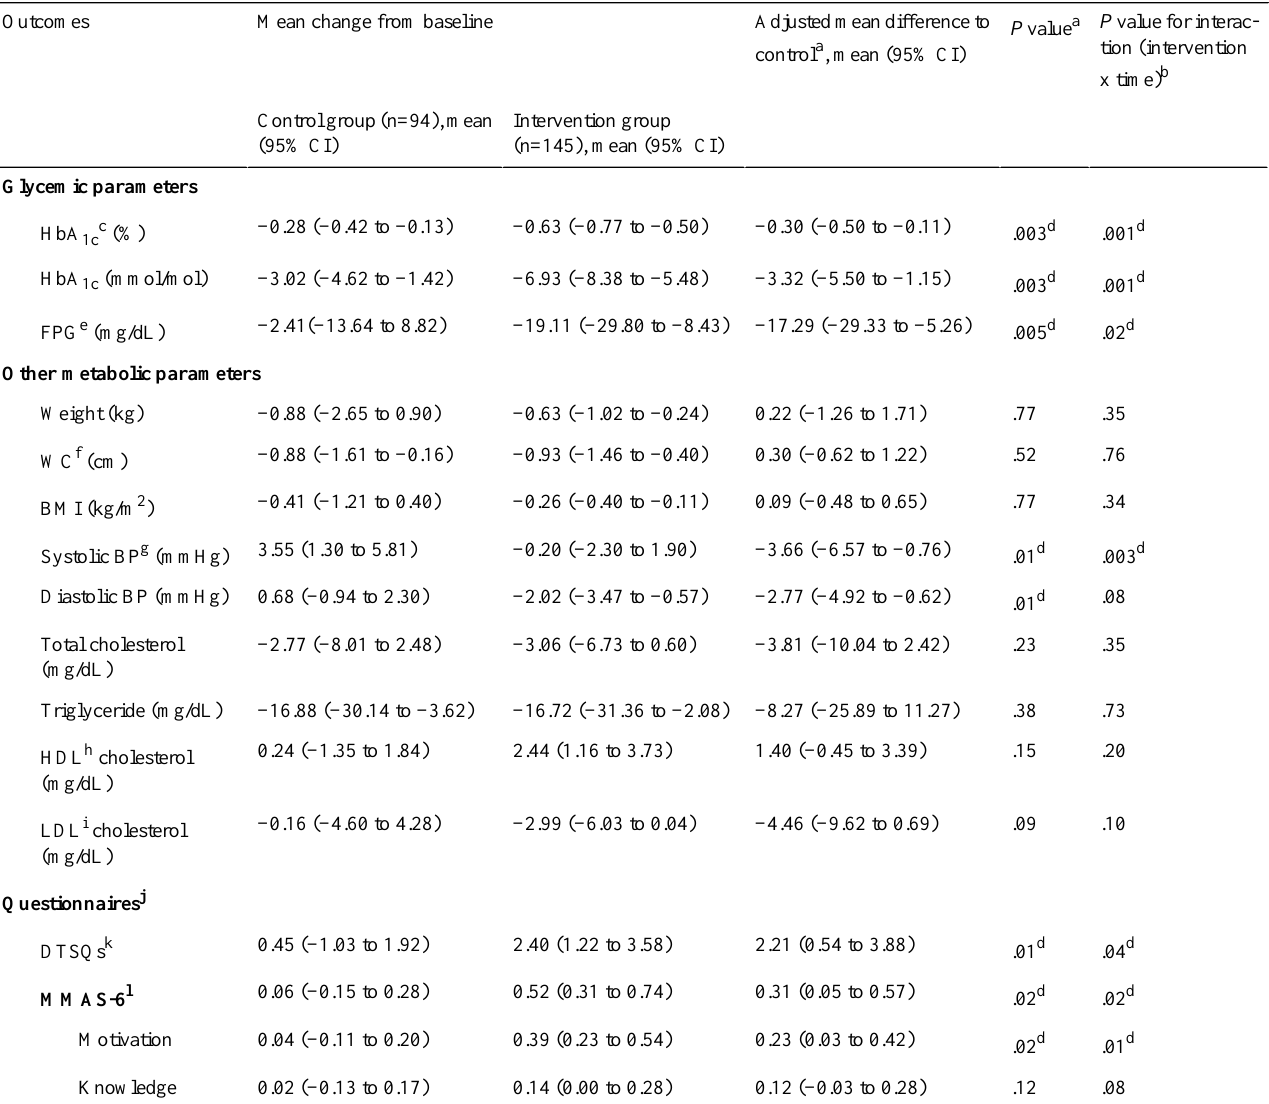
Table 2. Changes in efficacy outcomes between control and intervention groups at 3 months.